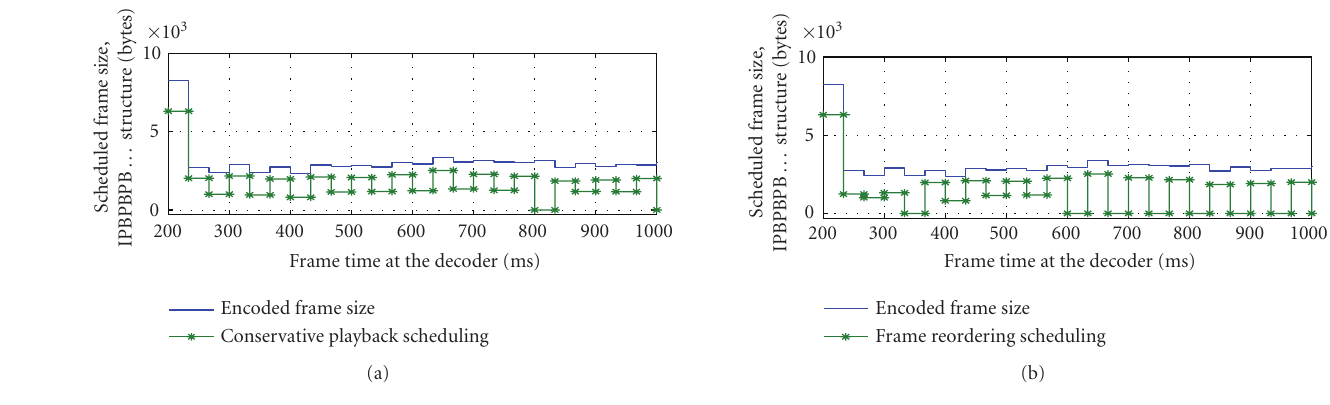
Figure 7: Example of conservative δ and frame reordering scheduling.